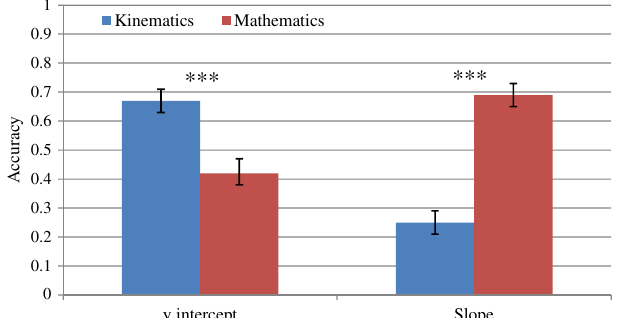
FIG. 5. GEE results for the term context * QType . The p value of the comparisons is indicated by * for p < 0 . 05 , ** for p < 0 . 01 , *** for p < 0 . 001 . Highly significant differences are found between the contexts for compare given a graph and for determine given a formula question